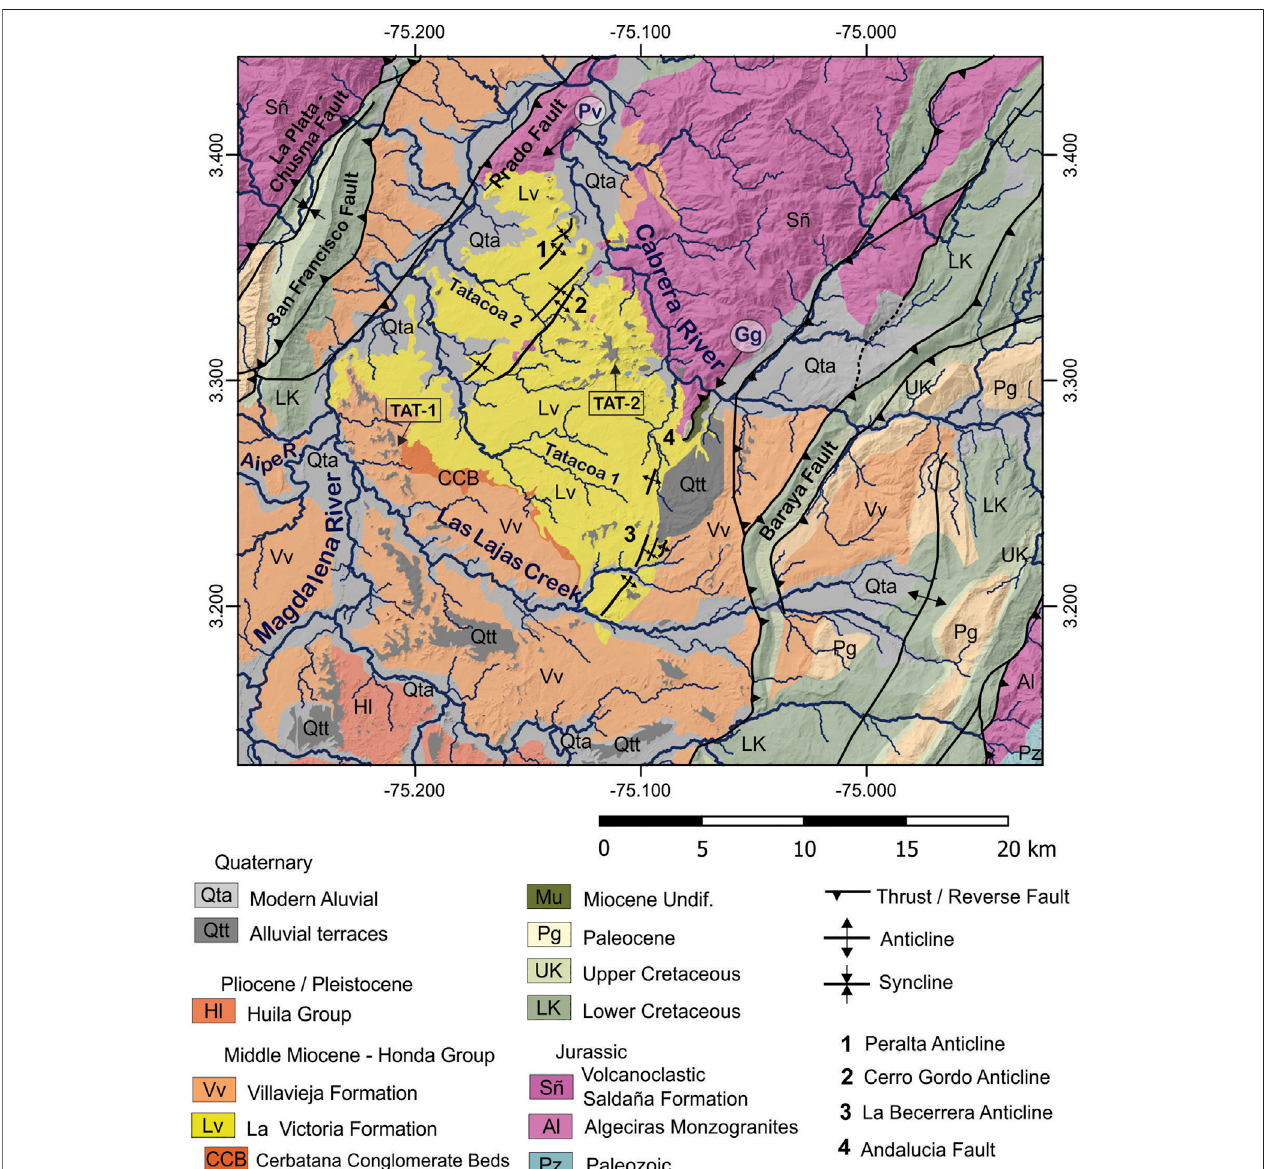
FIGURE2| Simpli fi edgeologicalmapoftheTatacoaDesertandthelocationofthe fl uvialterracessampledforopticallystimulatedluminescencedating(TAT-1and 2). Modi fi ed from Gómez et al. (2015) and Montes et al. (2021). Pv is a palleovaley and Gg is the Gorge of the Cabrera River. For a regional overview, a stratigraphic column of the Upper Magdalena Valley, simpli fi ed from Terraza – Melo et al. (2019) is shown in Supplementary Figure S2 .